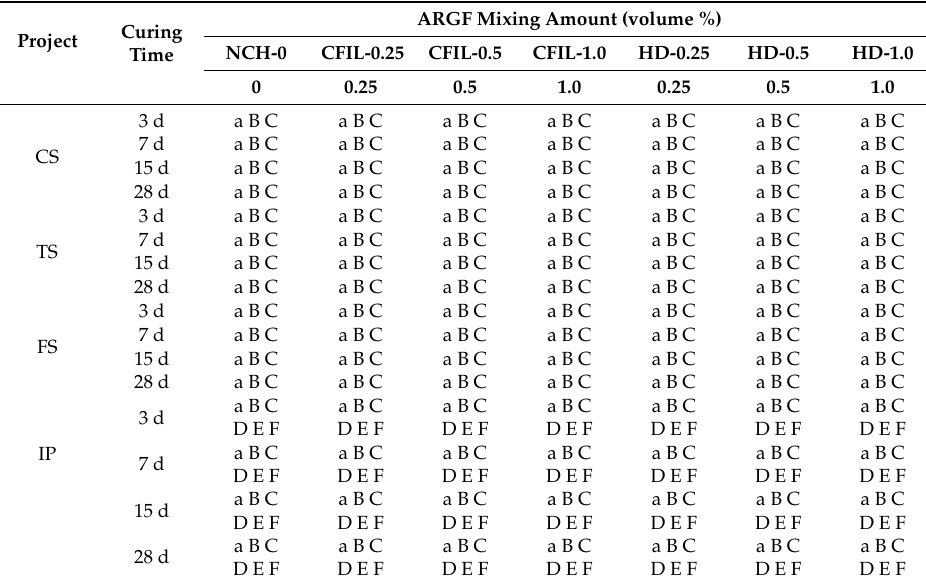
Table 3. Experimental group design